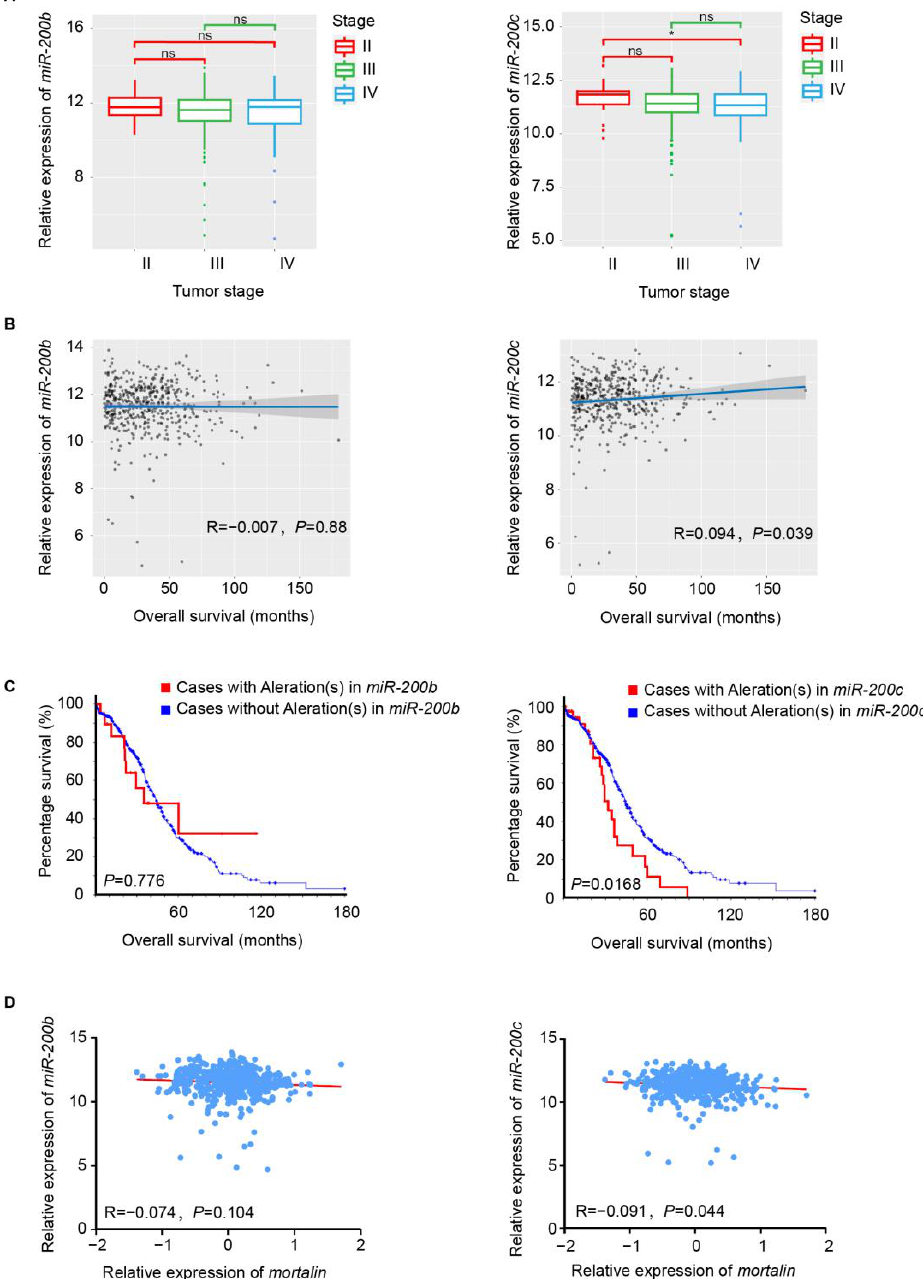
Figure 5. miR-200c expression levels are associated with patient prognosis. ( A ) Box diagram shows the correlation between miR-200b/c expression levels and different clinical stages (stages II, III, and IV) in TCGA 2011 ovarian cancer data (n = 489). ( B ) Scatter plot shows the correlation between miR-200b/c expression levels and the overall survival of patients with ovarian cancer. ( C ) Kaplan–Meier analysis indicates the correlation between miR-200b/c gene mutation and the overall survival of patients with ovarian cancer. ( D ) Scatter plot shows the correlation between miR-200b/c and mortalin expression levels in patients with ovarian cancer. * p < 0.05, ns p >